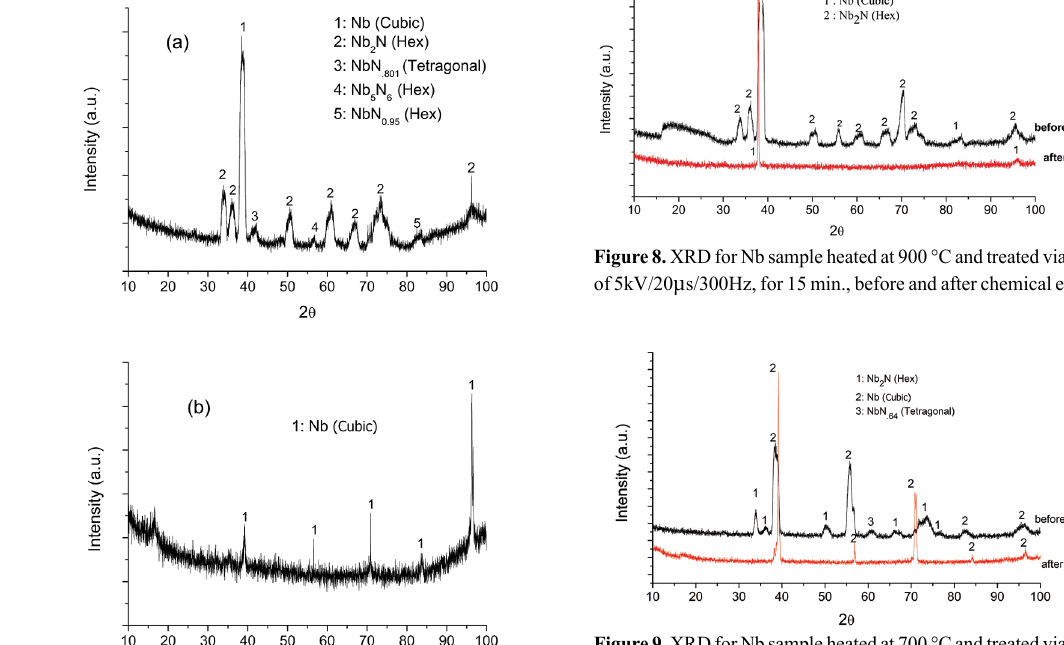
Figure 9. XRD for Nb sample heated at 700 °C and treated via pulses of 5kV/20 μ s/300Hz, for 15 min., before and after chemical etching.